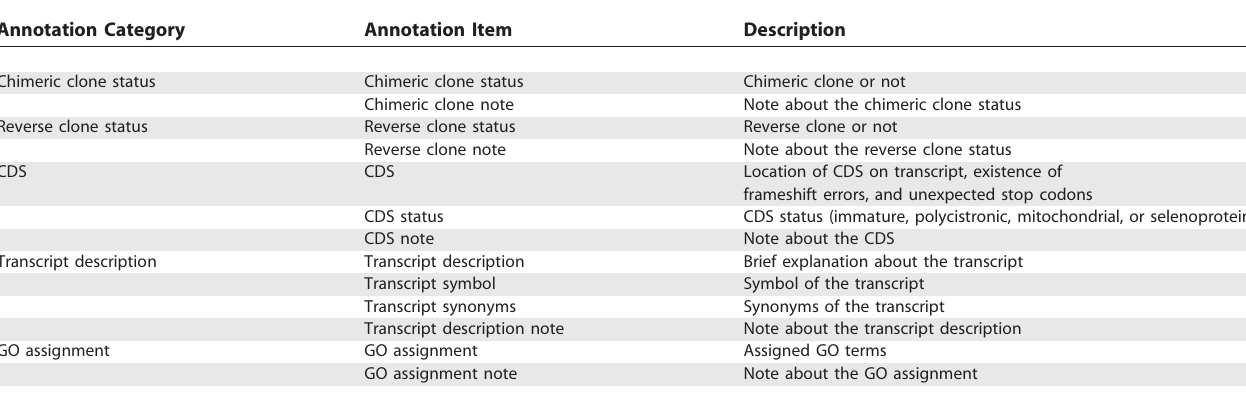
Table 1. Annotation Items in